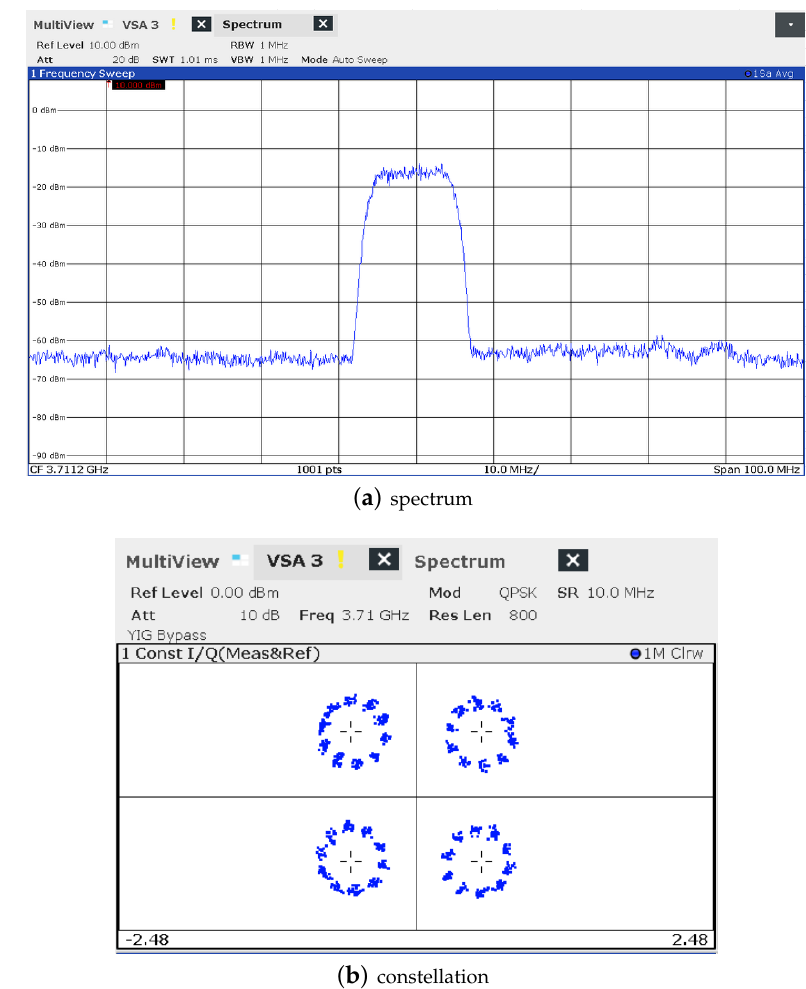
Figure 11. In-band interference. Measured spectrum ( a ) and constellation in the I/Q plane ( b ) at the output of the receiver breadboard (Ka-band front-end, SDR and demodulator) for a QPSK signal at 40Msym/s. The modulated signal has an available power of − 60dBm and is centered at 28.6495GHz. An interferer is added at the receiver input. The interferer is a − 60dBm carrier at 28.6505GHz (i.e., at 1-MHz offset). This justifies the rotation of the received data around the expected ( in the I/Q